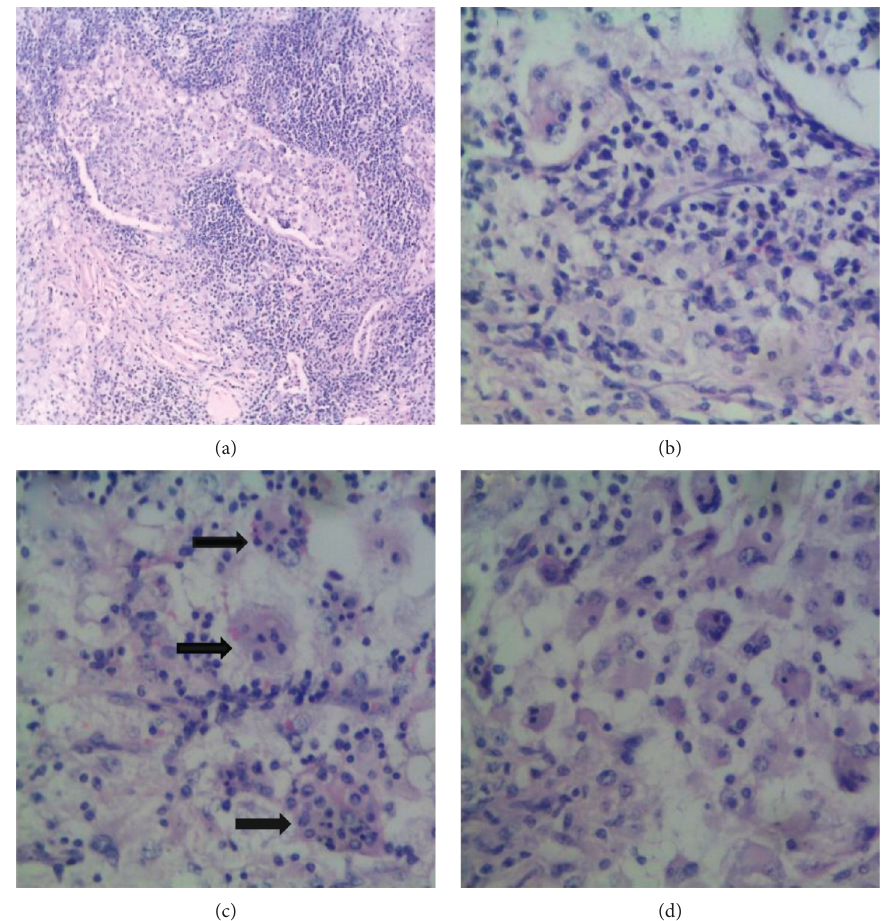
Figure 1: (H&E x400)- shows effacement of nodal architecture by diffuse sheets of histiocytes with abundant eosinophilic cytoplasm (a) and surrounding lympho-plasmacytic infiltrate (b). Areas where the histiocytes engulf intact chronic inflammatory cells are referred to as emperipolesis (black arrows)